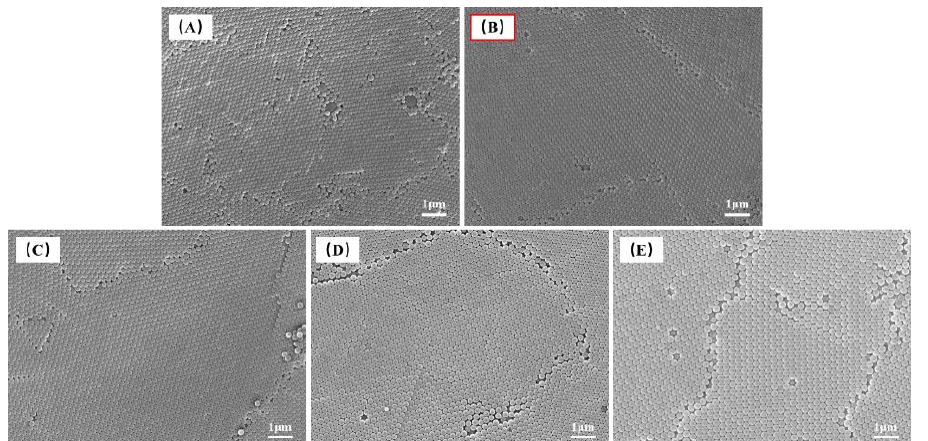
Figure 6. FE-SEM images of PSt colloidal microspheres synthesized with different reaction temper- ature: ( A ) 65 °C; ( B ) 70 °C; ( C ) 75 °C ( D ) 80 °C; ( E ) 85 °C.